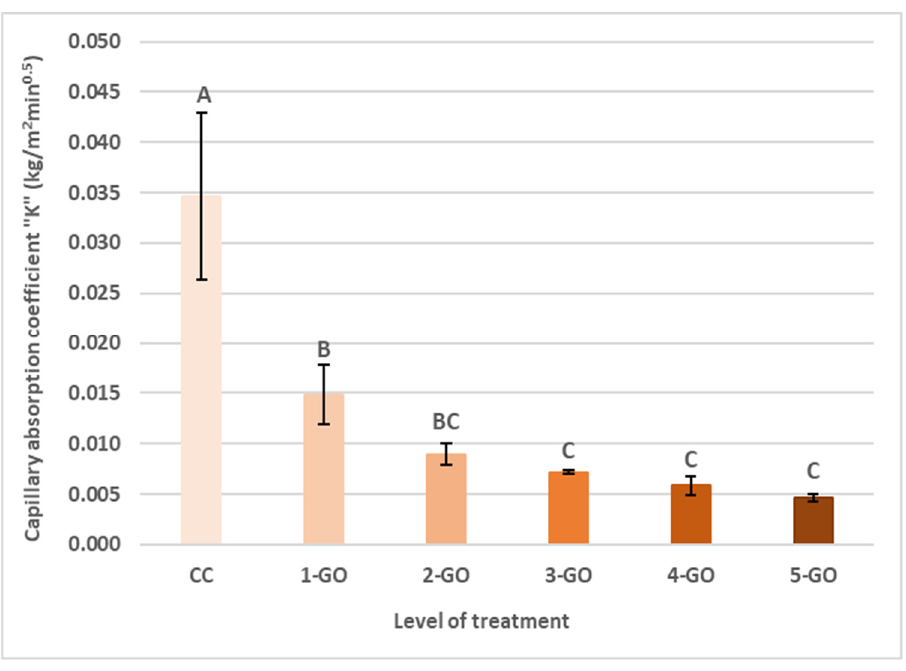
Figure 3. Coefficient of capillary water absorption at different treatment levels. Capital letters indicate minimum significant differences between treatment levels. Vertical bars represent the mean and the standard error (SE). Statistical differences are indicated by different letters (LSD test, p < 0.05).